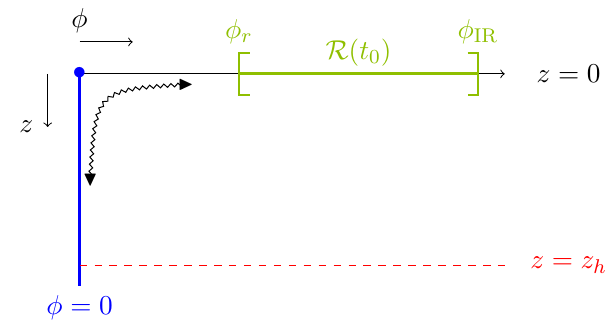
black hole with 2